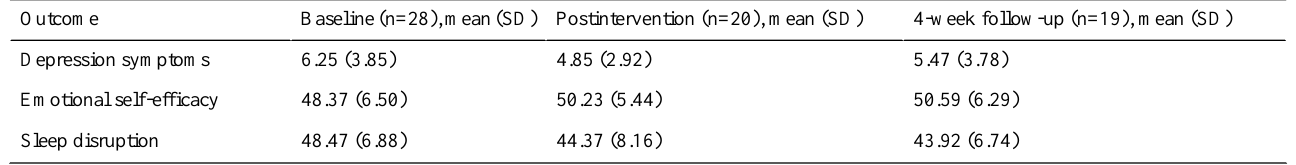
Table 3. Means and standard deviations of psychosocial outcomes at each time